Question: Write a descriptive caption for this figure.
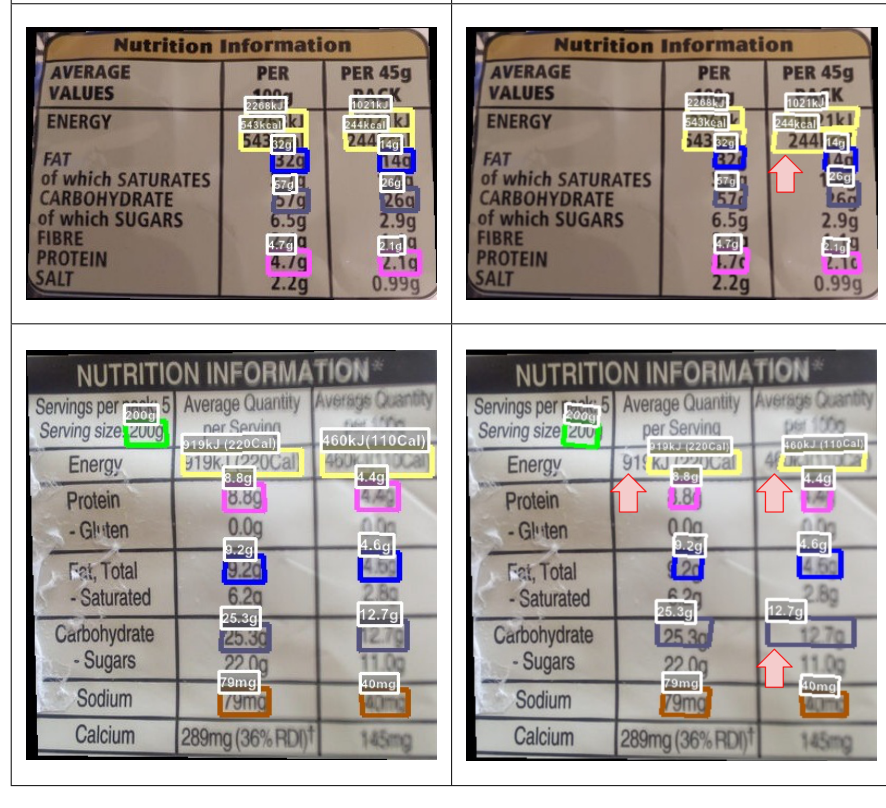
Answer: Comparison of Cases of Supervised and Weakly-Supervised Learning. Both approaches successfully capture the center points of the text. However, there was a difference in how accurately the model extracted the boundaries of the text boxes.